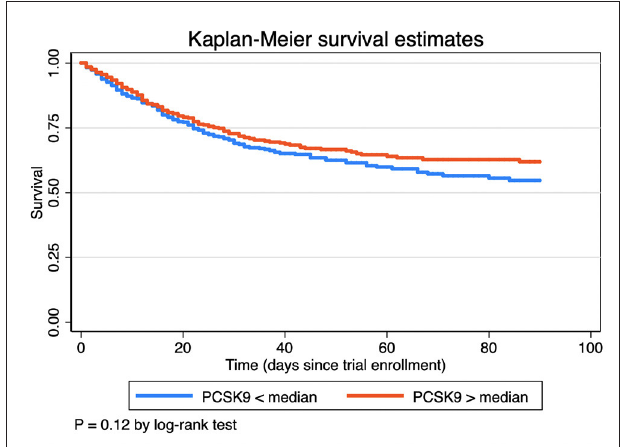
FIGURE 2 | Kaplan-Meier curves for 90 day mortality as a function of PCSK9 greater or less than the median value.